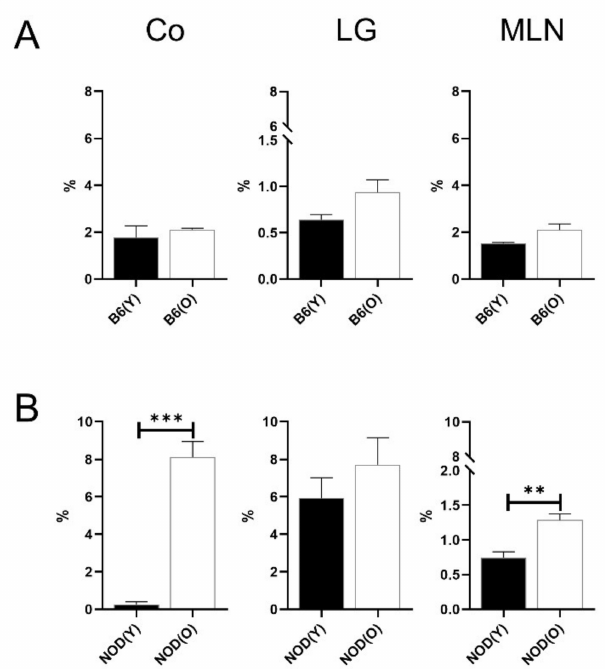
Figure 4. Distribution of CD103 + CD11b − DCs in B6 ( A ) ( n = 4) and NOD.B10.H2 b ( B ) mice ( n = 4). The total number of CD45 + cells was used as the denominator to compensate for the actual fraction of each subset in corneolimbus and LG. In MLN, the percentage of subsets was calculated as the percentage within total cells. The percentage of MLN CD103 + CD11b − DCs was significantly higher in aged NOD.B10.H2 b mice than in young NOD.B10.H2 b mice ( p = 0.004). Correspondingly, the percentage of corneolimbal CD103 + CD11b − DCs was markedly higher in aged NOD.B10.H2 b mice than in young NOD.B10.H2 b mice ( p < 0.001). All experiment results were tested for statistical differences using unpaired, two-tailed independent t -tests. Data are expressed as the mean ± standard error of the mean. B6, C57BL/6; NOD, NOD.B10.H2 b ; DC, dendritic cell; CO, corneolimbus; LG,